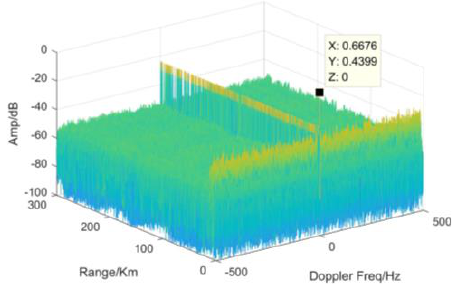
Figure 6. The CI of raw echoes.